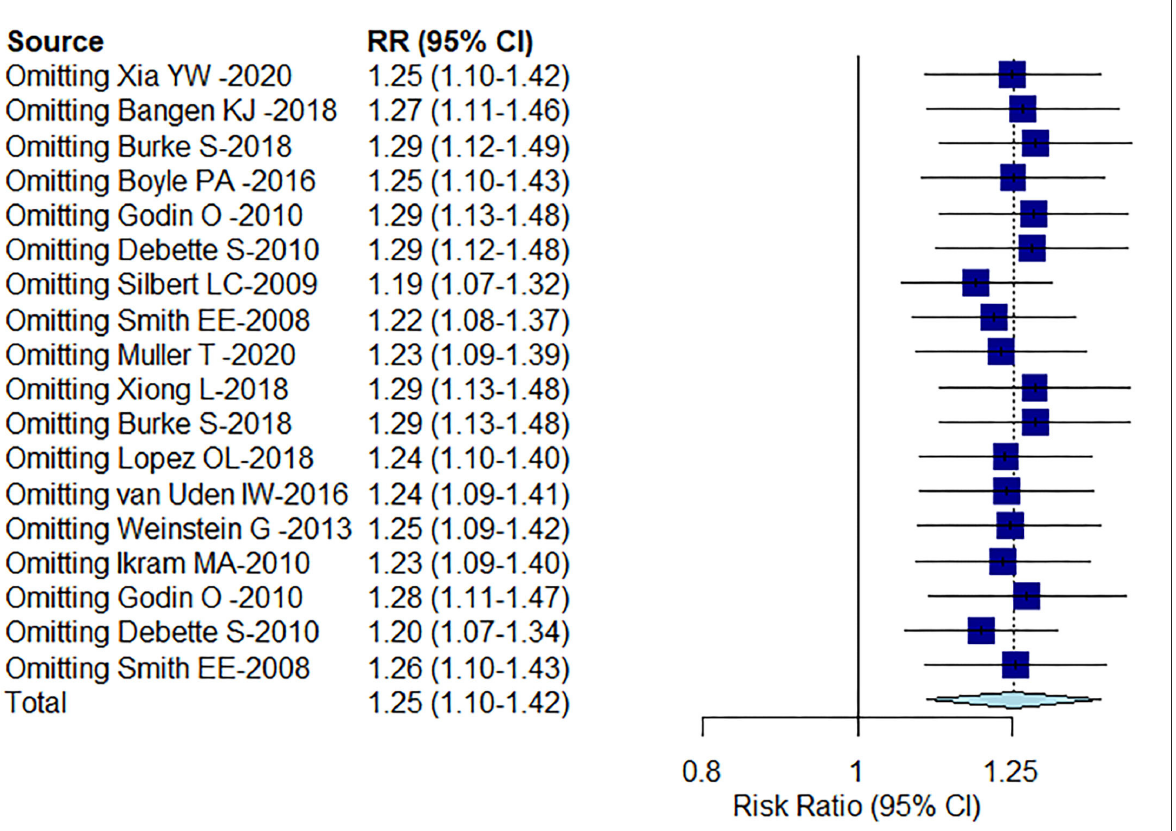
FIGURE6 Sensitivity analysis of the included literature on the correlation between WMH volume and